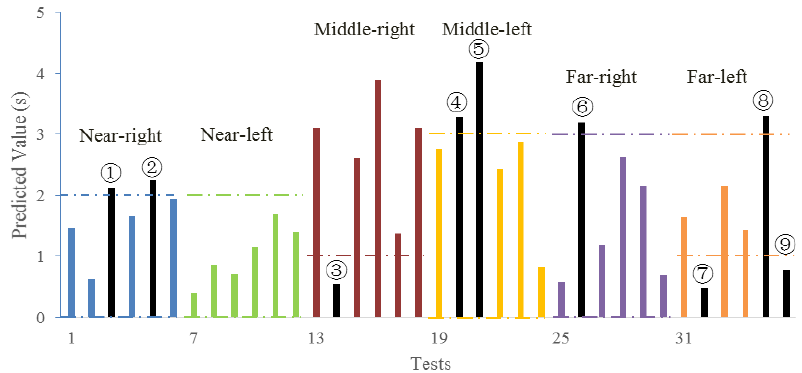
Figure 8. Results of 6 × 6 test. The numbered bars represent the tests with inappropriate PR time.